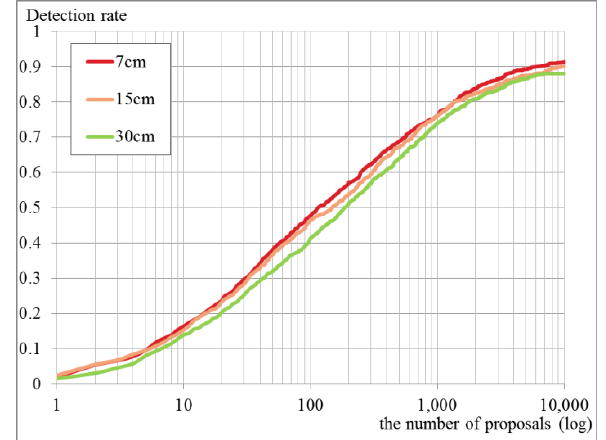
Figure 8. Comparison of detection rate between different spatial resolutions